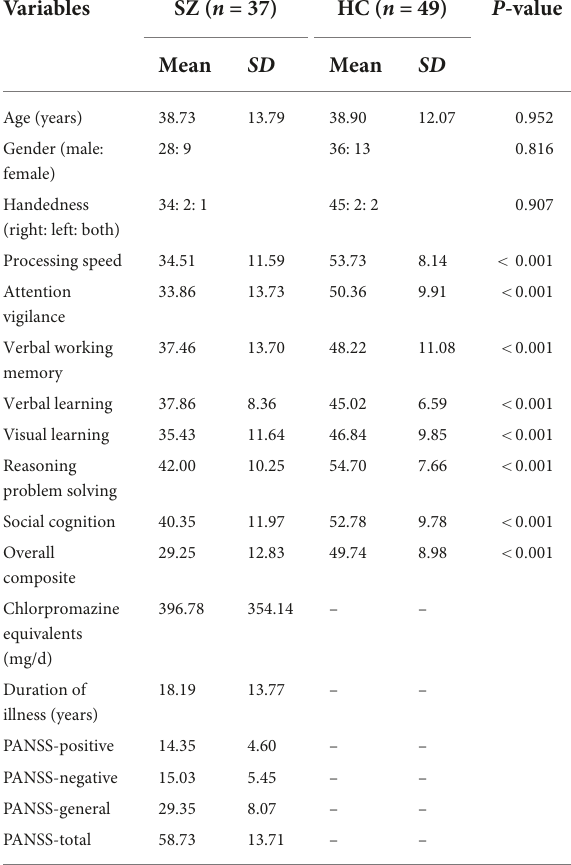
TABLE 1 Demographic characteristics of the schizophrenia patients and healthy controls.